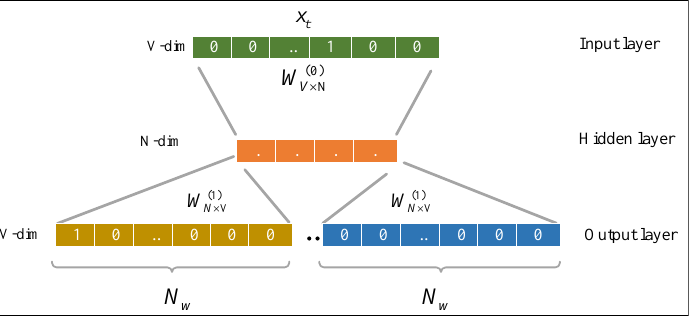
Figure 2. Skip-gram model architecture.